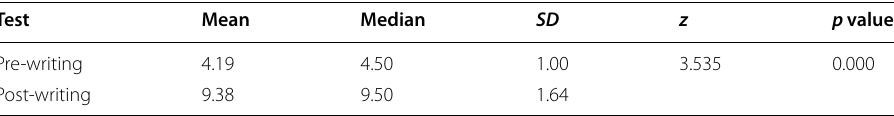
Table 6 Wilcoxon signed-rank test results of pre-post Writing Test Score ( N